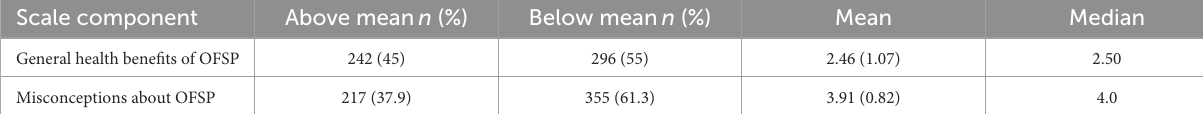
TABLE 5 Participant scores on the scale dimensions derived from factor analysis of knowledge of orange-fleshed sweet potatoes (OFSP).